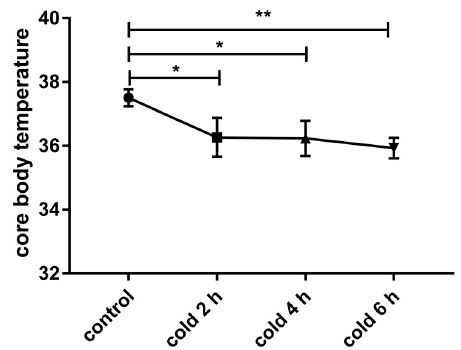
Figure 1. Effect of acute cold exposure on core body temperature in C57BL/6 mouse. The data are presented as the mean ± SEM ( n = 8). Statistically significant differences are indicated; * p < 0.05 and ** p < 0.01.